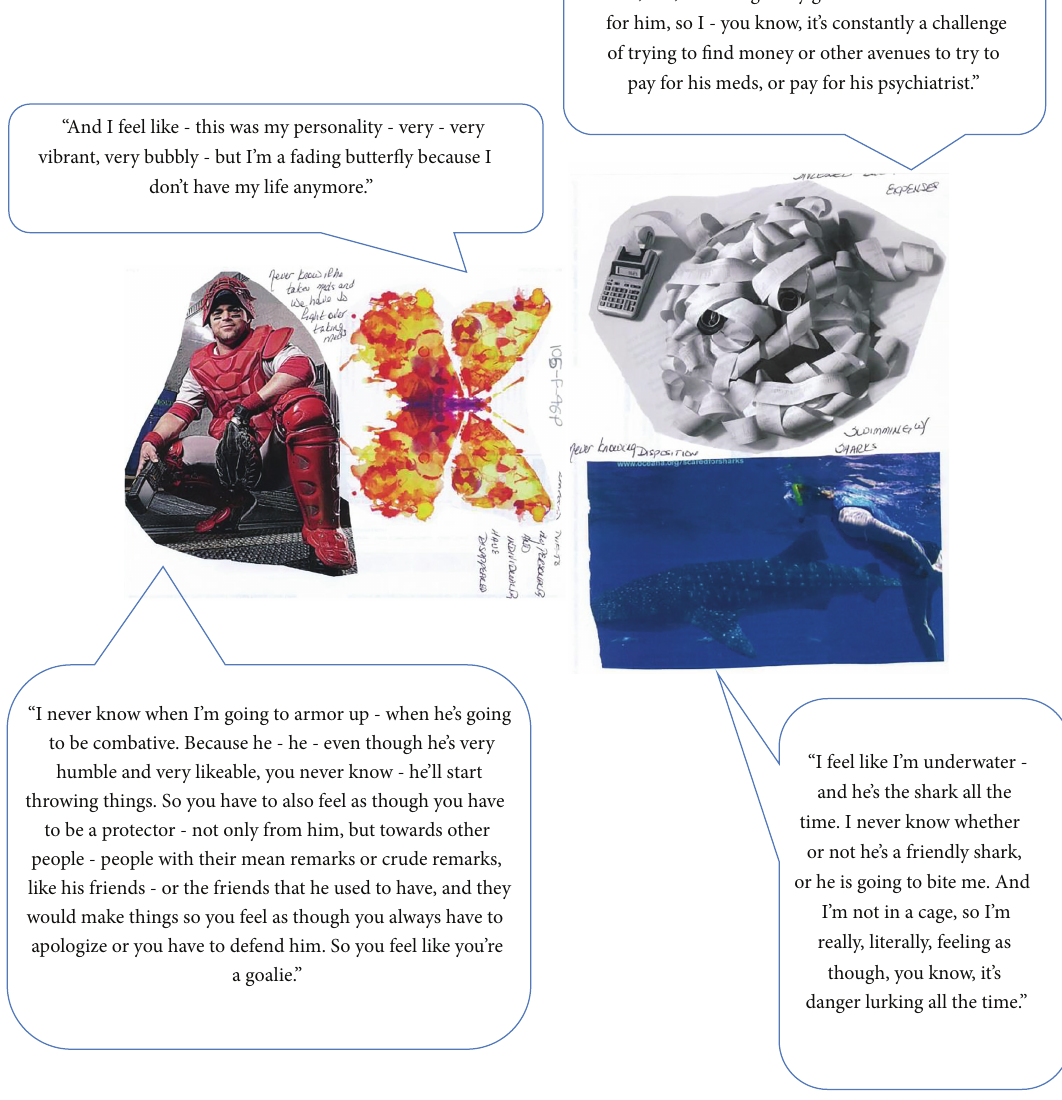
Figure 3: Caregiver ID: